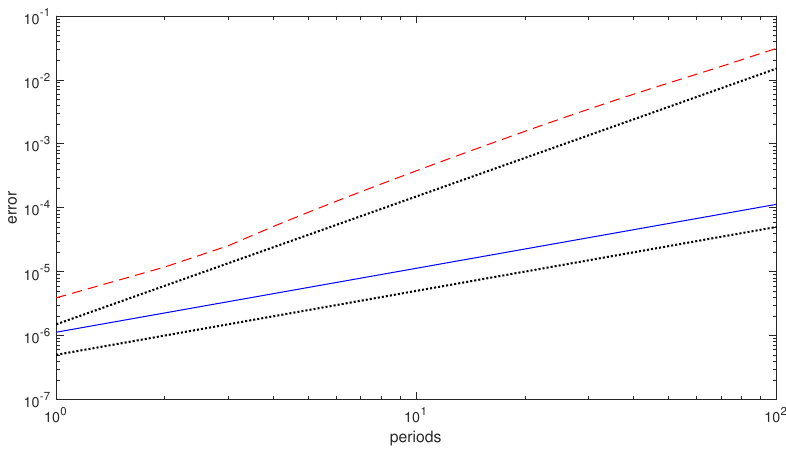
Figure 1. Error growth over 100 periods when solving problems (60) and (61) by using the EQUIP(6,3) method (blue solid line) and the 3-stage Gauss method (red dashed line) with stepsize h = T /50 ≈ 0.15. The dotted lines show the linear and quadratic error